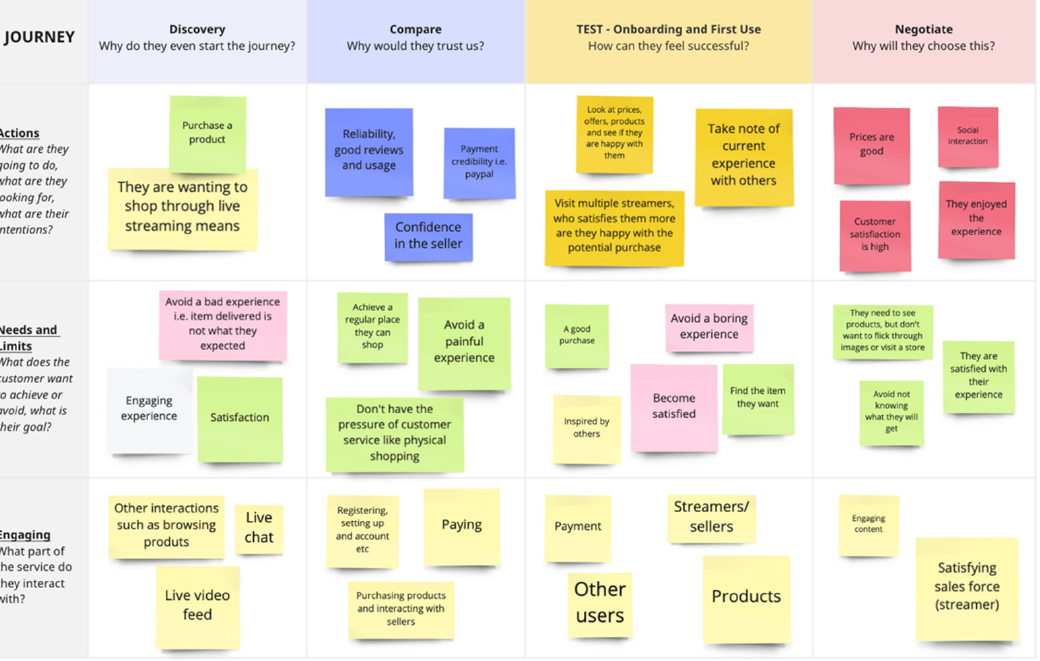
Figure 11. A screenshot from the Co-design Workshop Miro board, illustrating a customer journey map.